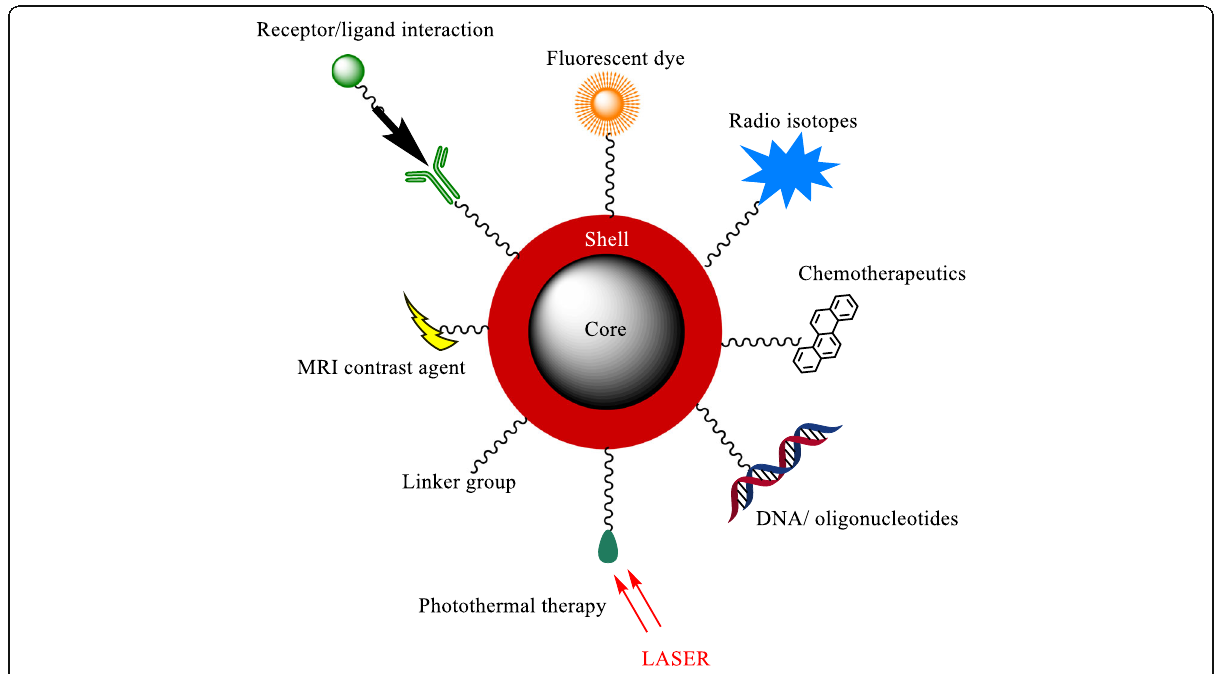
Fig. 7 A pictorial representation of the applications of core/shell